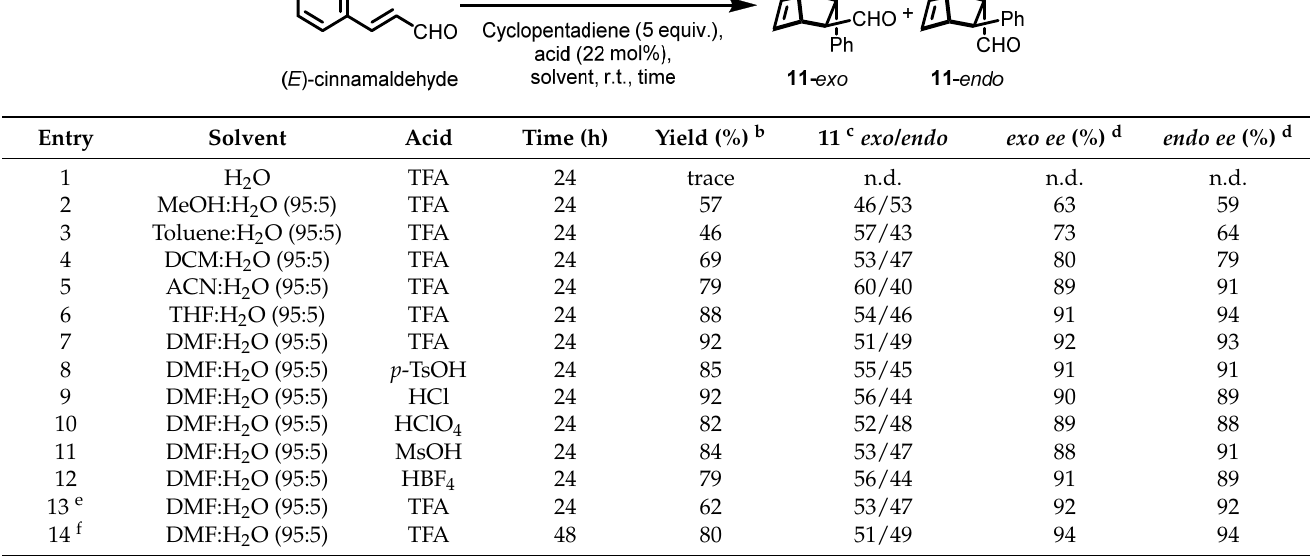
a Reaction conditions: 0.050 mmol (49 mg, 20 mol%) of the polysulfate catalyst 7a , 0.055 mmol (22 mol%) of the acid co-catalyst, 0.25 mmol (31 µ L, 1 equiv.) of ( E )-cinnamaldehyde, and 1.25 mmol (0.11 mL, 5 equivalent) of cyclopentadiene at room temperature in 0.50 mL of solvent. b Yield of isolated product. c Determined by 1 H NMR spectroscopy. d Determined by HPLC with a chiral OJ-H column after converting the products to the corresponding alcohol. e The reaction was performed with 10 mol% of polysulfate catalyst 7a and 11 mol% of TFA. f The reaction was performed at 0 ◦